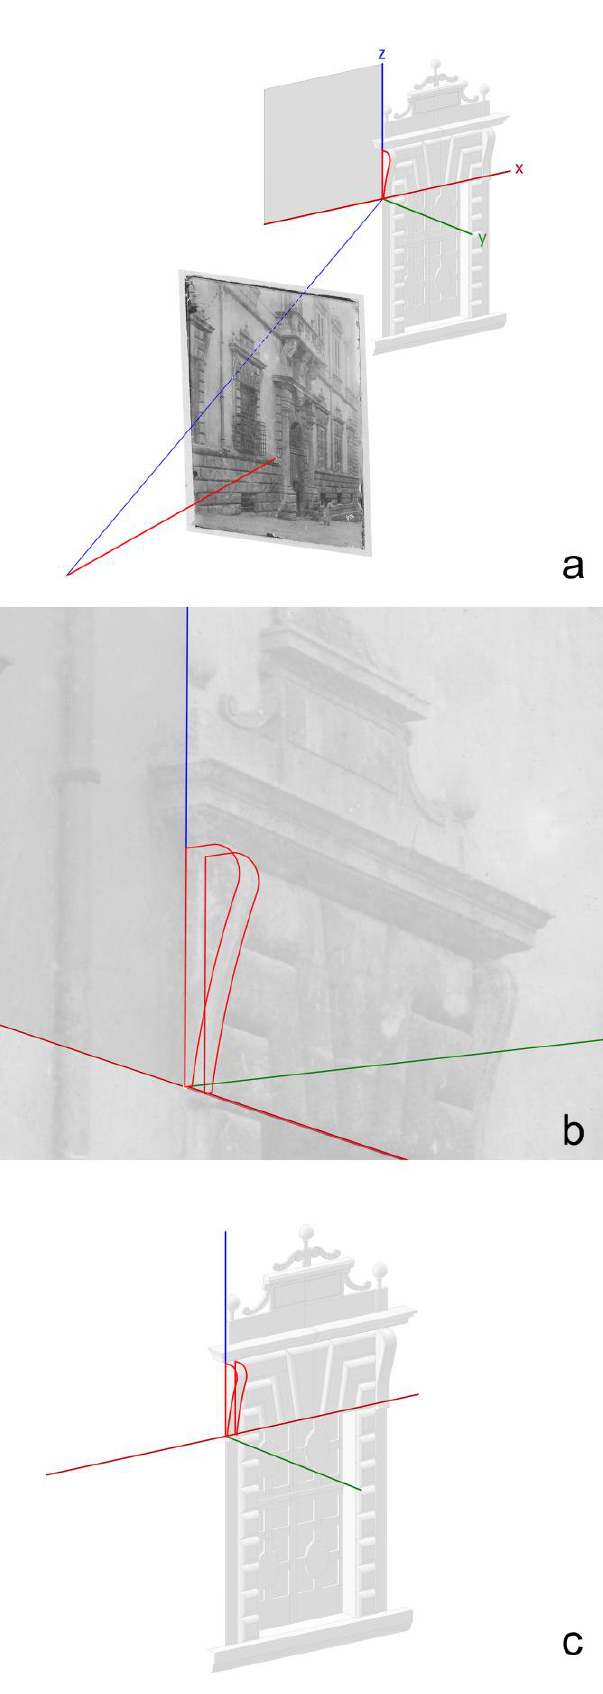
Figure 11 . Duplication of the profile of a